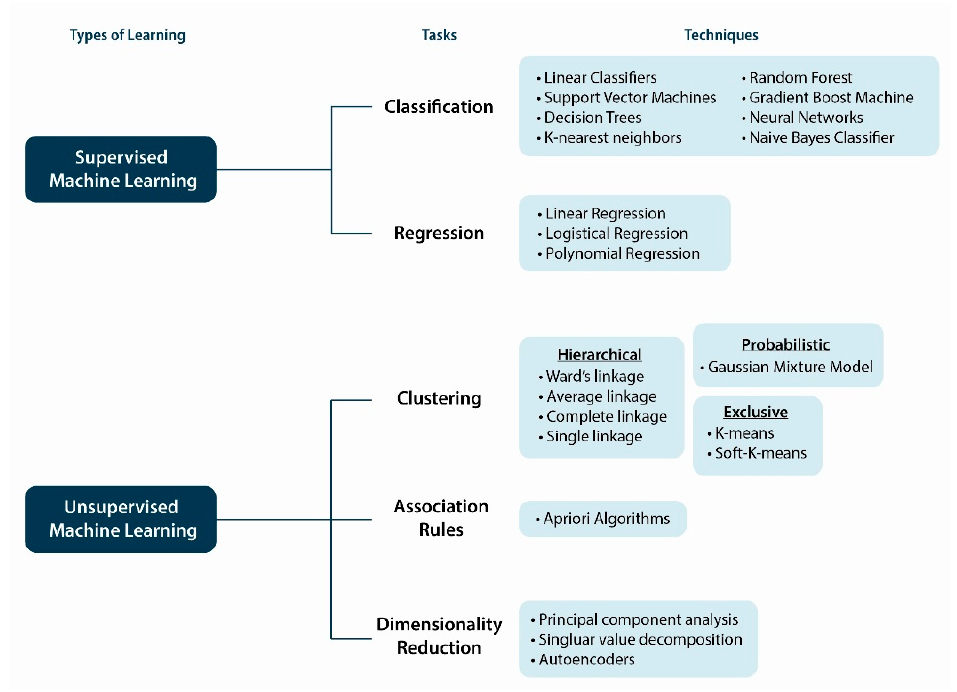
Figure 6. Tasks and techniques used in machine learning. There are many types of learning, but supervised and unsupervised machine learning types are already available and relatively easy to use in biomedicine.